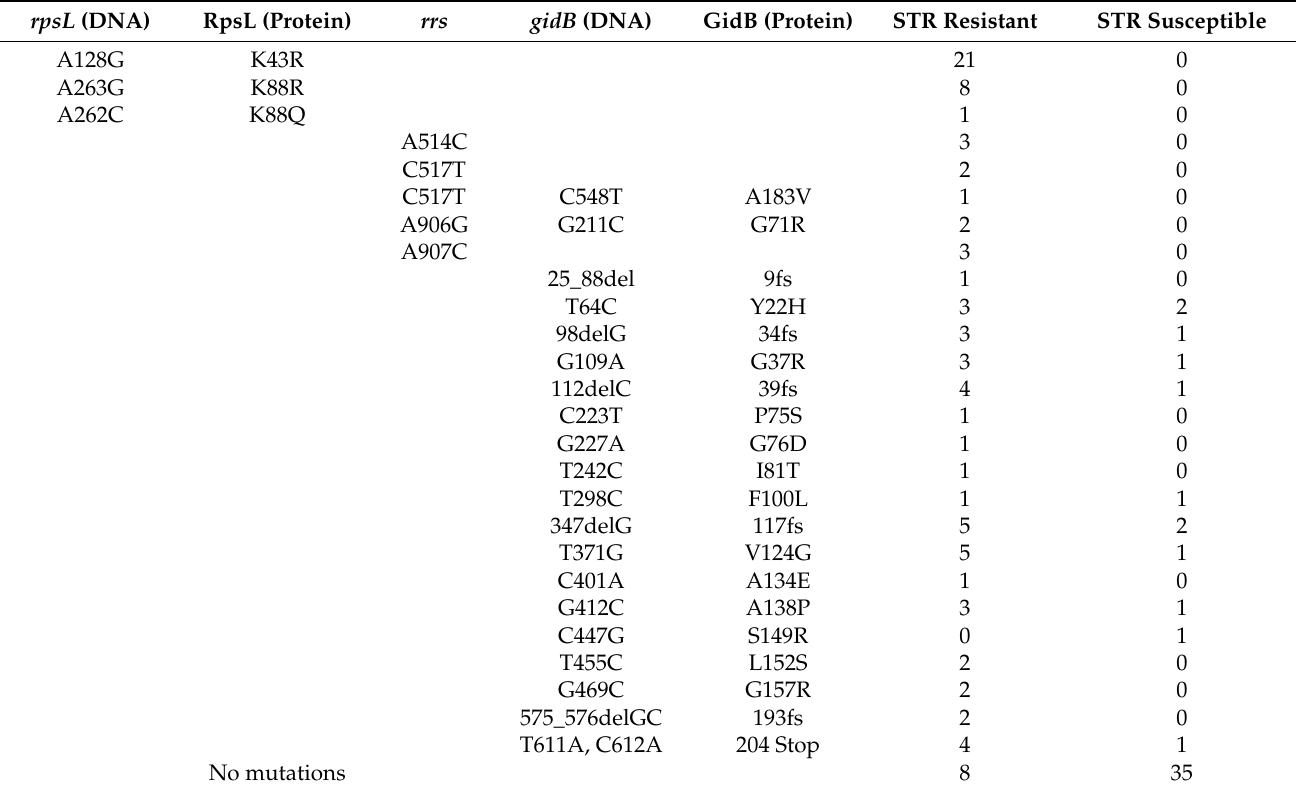
Table 2. Distribution of mutations in rpsL , rrs, and gidB among STR-resistant and susceptible